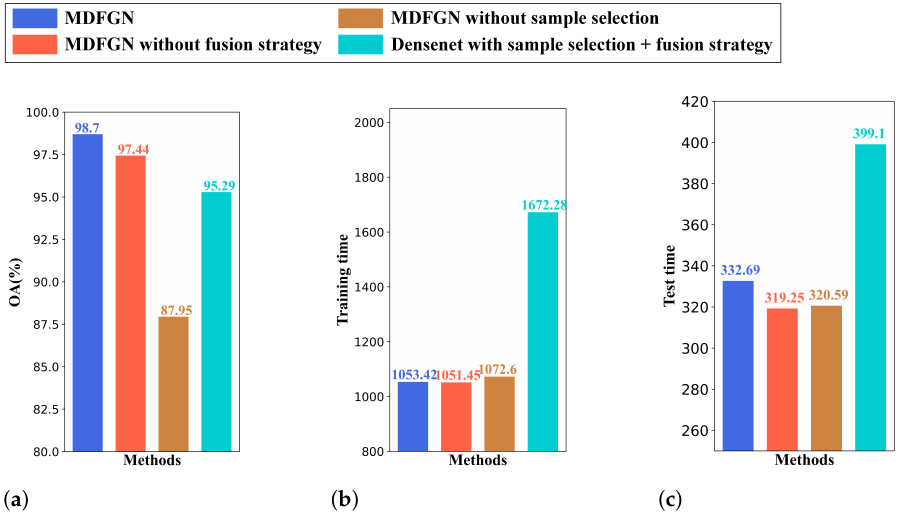
Figure 18. Model structures of 4 groups of ablation studies. ( a ) MDFGN; ( b ) MDFGN without fusion strategy; ( c ) MDFGN without sample selection; ( d ) DenseNet with sample selection + fusion strategy.